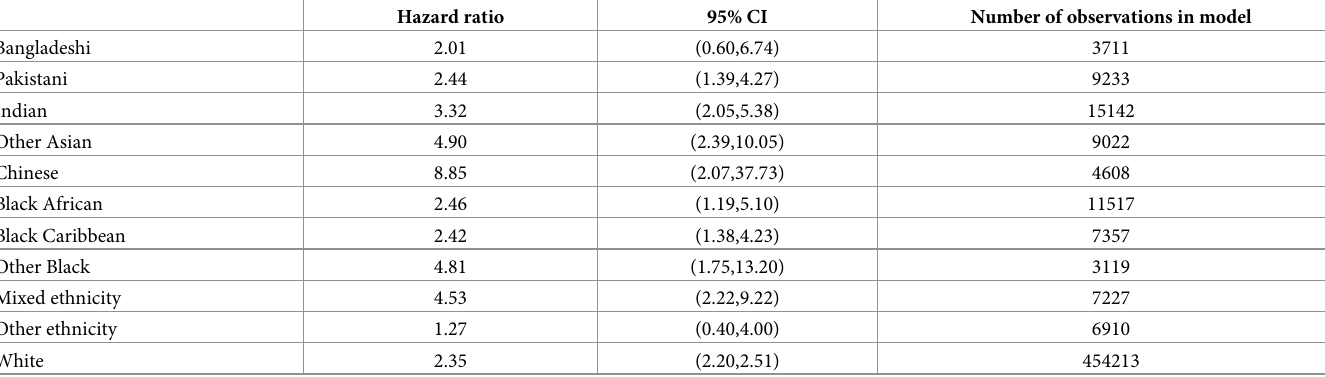
Table 4. Mortality associated with complex multimorbidity from ethnicity-stratified models.